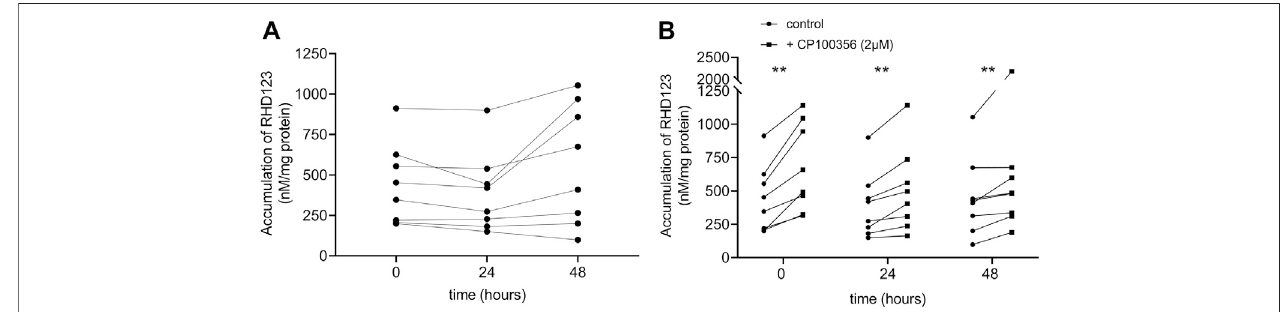
FIGURE3| AccumulationofRHD123analyzedinfreshhPCISsandhPCISsafterincubationfor24or48 h.Eachlinerepresentssamplescollectedfromonedonor. Corresponding calculated medians did not differ according to Kruskal – Wallis tests ( n (cid:2) 8) in the absence ofCP100356 (A) . The addition of2 µM CP100356 signi fi cantly increased the accumulation of RHD123 in hPCISs treated at all three time points ( n (cid:2) 8). Data are presented as a pairwise comparison showing individual donor values (control/CP100356-treated) together with indications of the signi fi cance of between-treatment differences according to the Wilcoxon signed-rank test (*, p < 0.05; **, p < 0.01) (B)